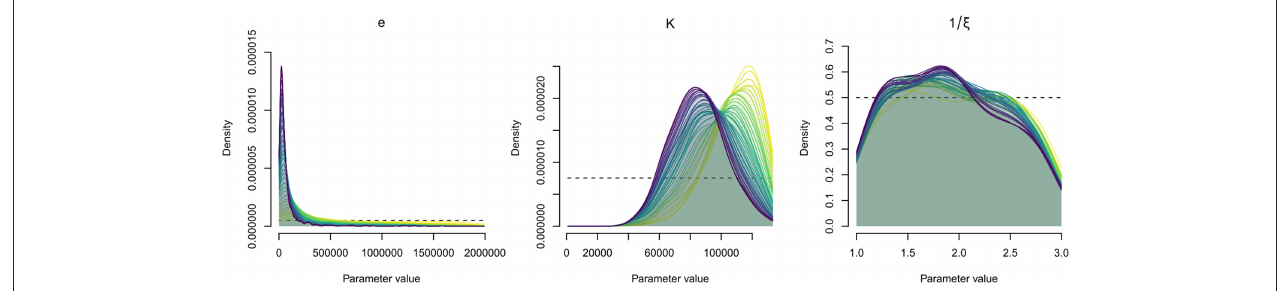
FIGURE 5 | Parameter estimation by Approximate Bayesian Computation (ABC). Distributions of probability density of the epidemiological parameters, for sequential simulation steps (39 steps, 157,000 simulations); e , bacteria shedding rate; K, concentration of bacteria in water that yields a 50% chance of catching the infection; 1/ ξ , free-living bacteria lifetime in seawater. The dotted lines show the prior distribution.